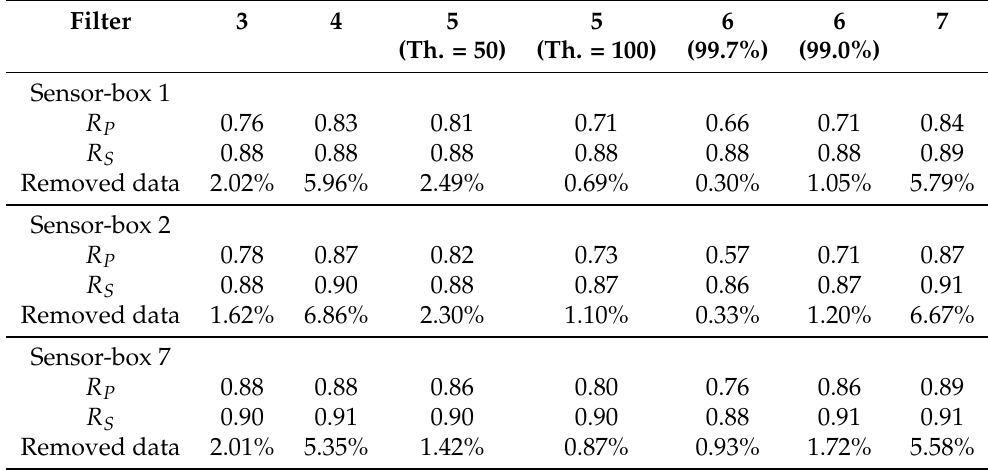
Table A4. Results of sliding window filtering methods applied to raw PM 10 data: correlation between sensor-box and in-luft data versus removed data. Window size = 20,000 data